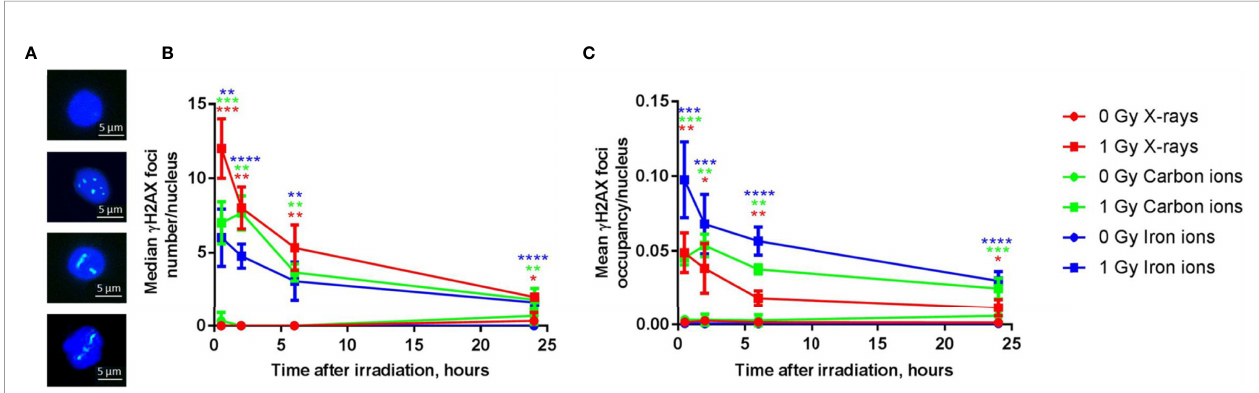
FIGURE 8 | DNA repair kinetics after exposure to different types of radiation. (A) Representative examples of immunostained g H2AX foci in PBMCs 6 h following (from top to bottom) sham-irradiation, exposure to 1 Gy of X-rays, iron ions or carbon ions. (B) The number of g H2AX foci per nucleus after exposure to 1 Gy of X-rays, carbon and iron ions at different time points (median of three biological replicates for X-rays and carbon ions and four biological replicates for iron ions, error bars represent standard deviations). (C) The occupancy of g H2AX foci per nucleus (average of three biological replicates for X-rays and carbon ions and four biological replicates for iron ions, error bars represent standard deviations) after exposure to 1 Gy of X-rays, carbon and iron ions at different time points. Statistical comparison between irradiated and sham-irradiated samples was performed using unpaired t -test (* p < 0.05, ** p < 0.005, *** p < 0.001, **** p <